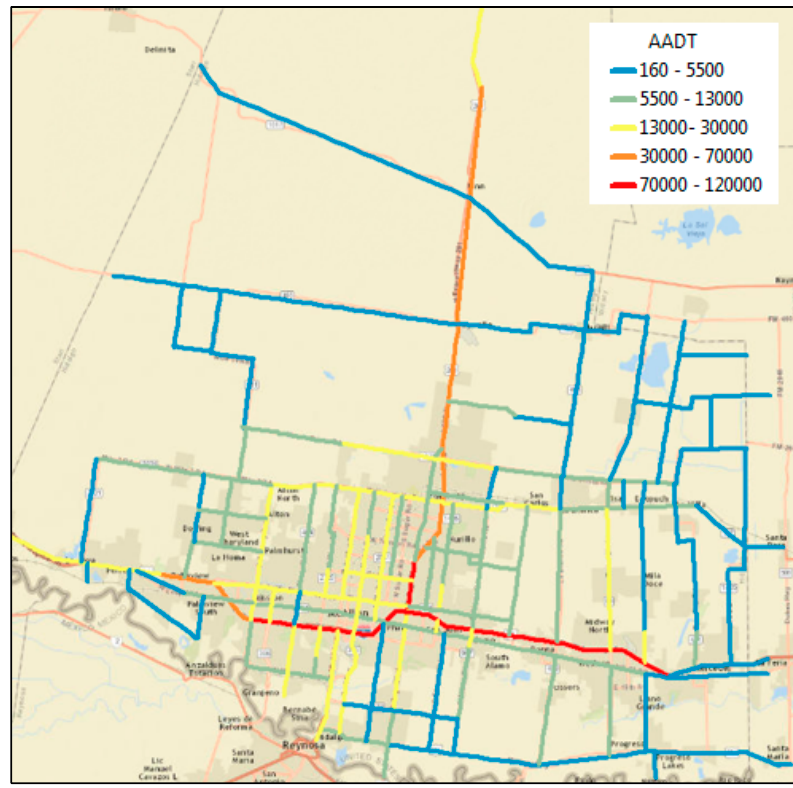
Figure 4. Traffic activities (annual average daily traffic (AADT)) across the study